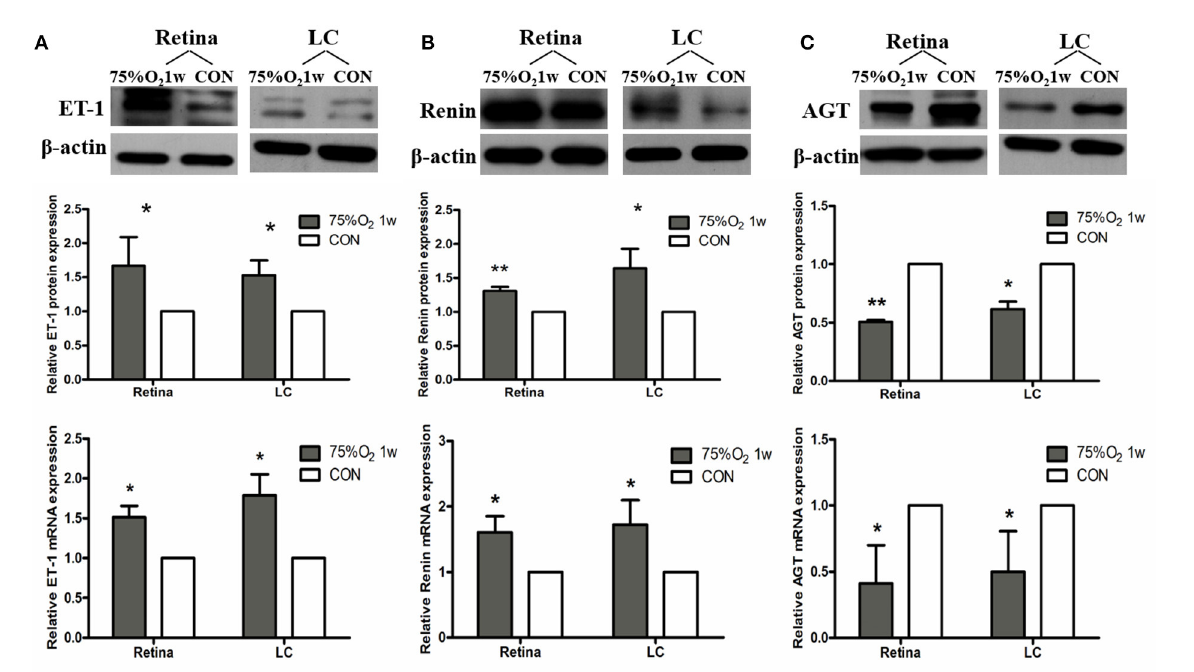
FIGURE5 Hyperoxia induced vasoconstriction in rat retina via up-regulation of ET-1 and RAS. (A) Protein and mRNA expression of ET-1 in retina and LC significantly increased after 75%O 2 exposure for 7 days. (B) Protein and mRNA expression of renin in retina and LC significantly increased after 75%O 2 exposure for 7 days. (C) Protein and mRNA expression of AGT in retina and LC significantly decreased after 75%O 2 exposure for 7 days. * p < 0.05, ** p < 0.01, LC, Lamina cribrosa; ET-1, Endothelin 1; RAS, Renin-angiotensin